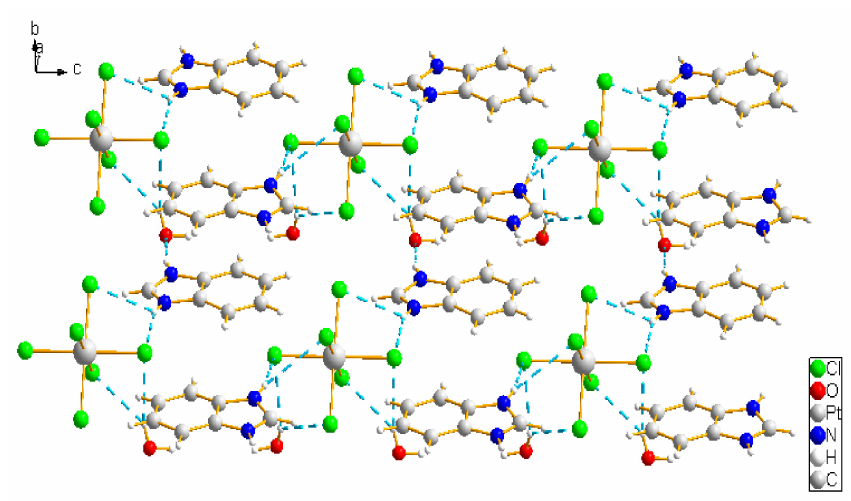
Figure 2. Hydrogen-bonded motifs for complex 1 . Hydrogen bonds are shown as dashed lines.